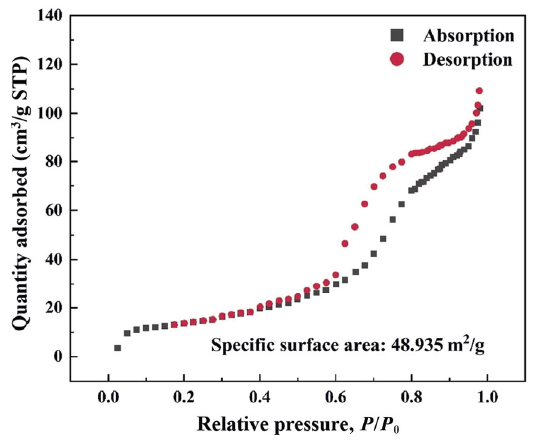
Fig. 5 Typical N 2 adsorption–desorption isotherm of 5Ag–In.